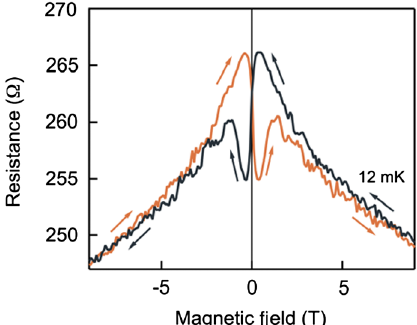
FIG. 3. (a) Magnetoresistance of a La-doped SrTiO 3 film with a carrier density of 9 (cid:2) 10 20 cm (cid:1) 3 at 12 mK, showing hysteresis during sweeps with increasing and decreasing B , respectively.